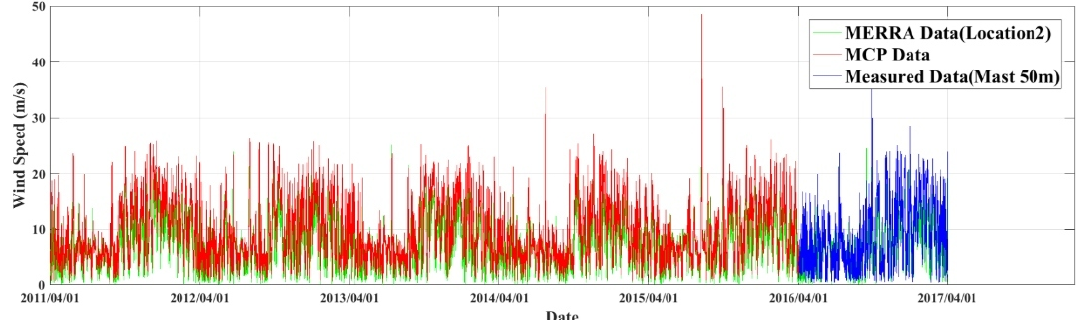
Figure 14. Time series of wind speed at mast (95 m height) with MCP by using data measured at mast and MERRA location 2.